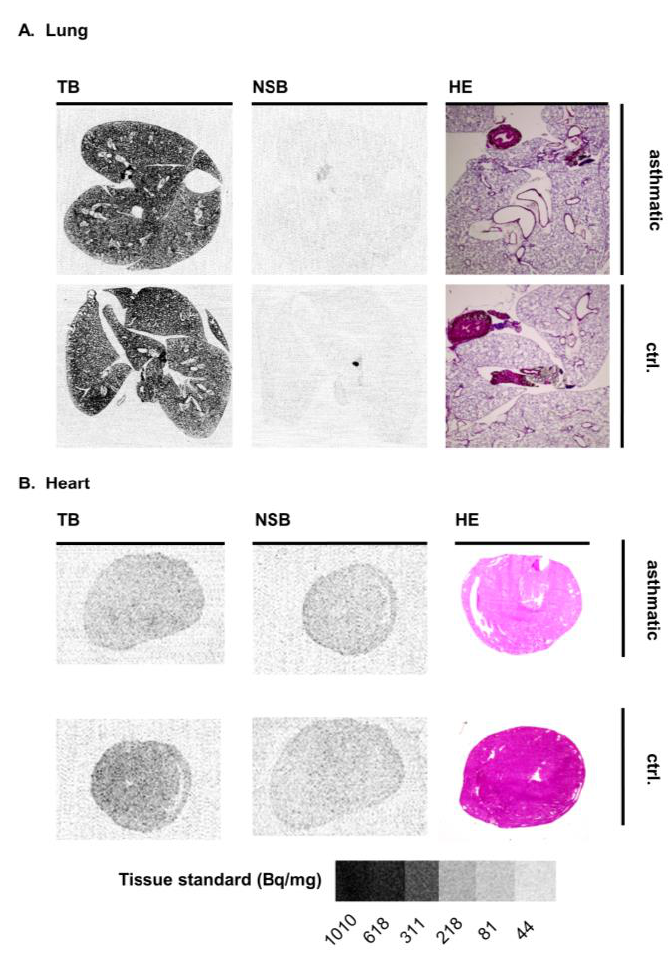
Figure 4. Representative images of ( A ) lung and ( B ) heart tissue sections obtained from BALB/c mice, which were either exposed to ovalbumin to induce symptoms of acute asthma (asthmatic) or were left untreated (ctrl.). TB, total radioligand binding; NSB, non-specific binding (determined in the presence of 5 µM FR), HE, hematoxylin-eosin staining. For autoradiography, organ slices were incubated with 10 nM [³H]PSB-15900-FR for 1 h at room temperature. Tissue equivalent standards are displayed at the bottom.